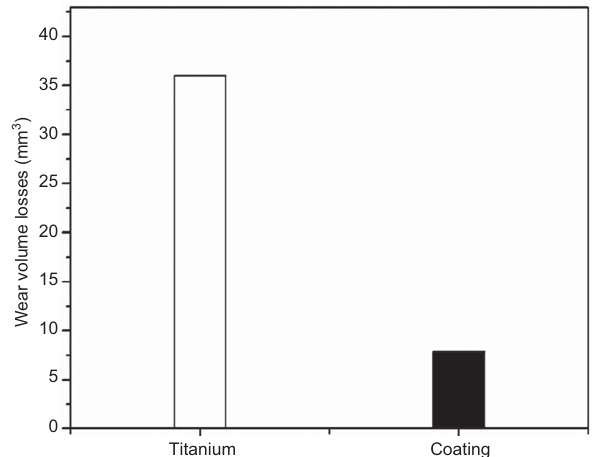
Figure 4 Wear volume losses of the composite coating and